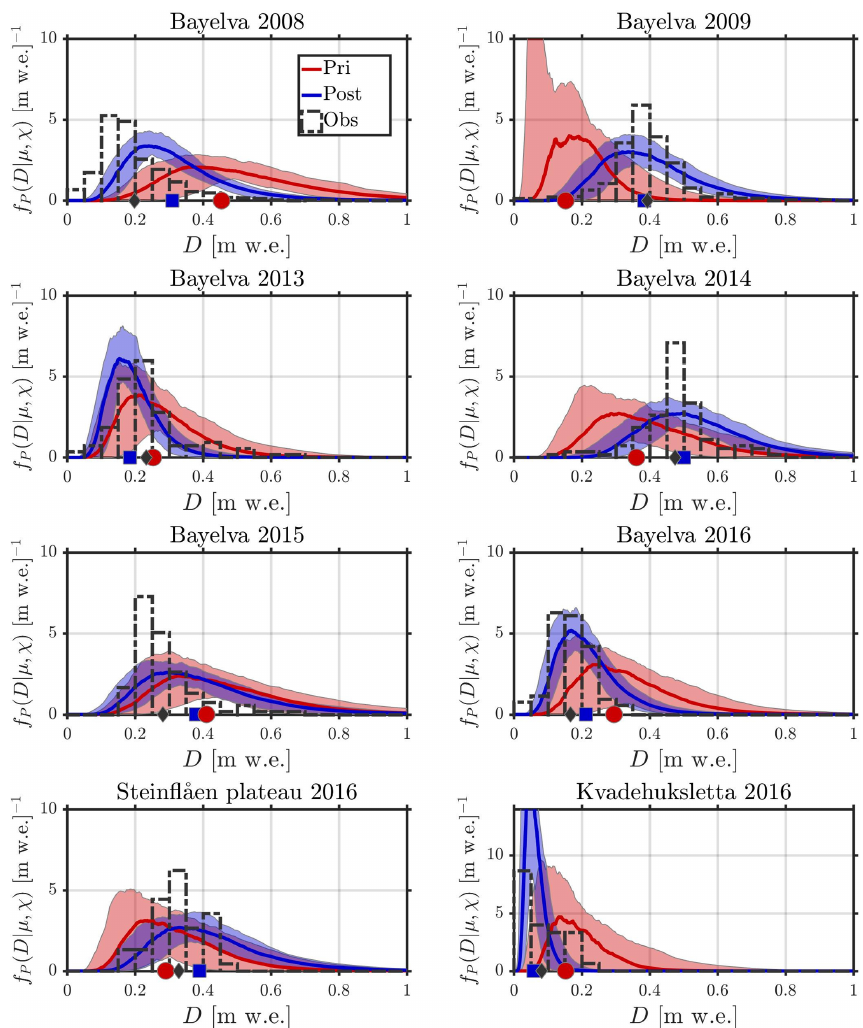
Figure 5. Prior (red), ES-MDA ( N a = 4, N e = 10 2 ) posterior (blue) and the corresponding independently observed (from snow surveys; dashed black) peak subgrid SWE distributions; shaded areas: 90th-percentile range; solid lines: ensemble median; markers: mean value. These results are from a single